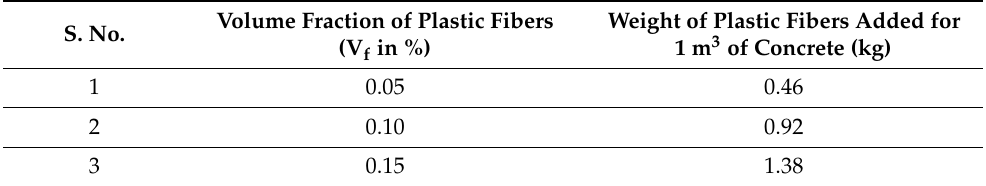
Table 4. Fiber proportions used in this